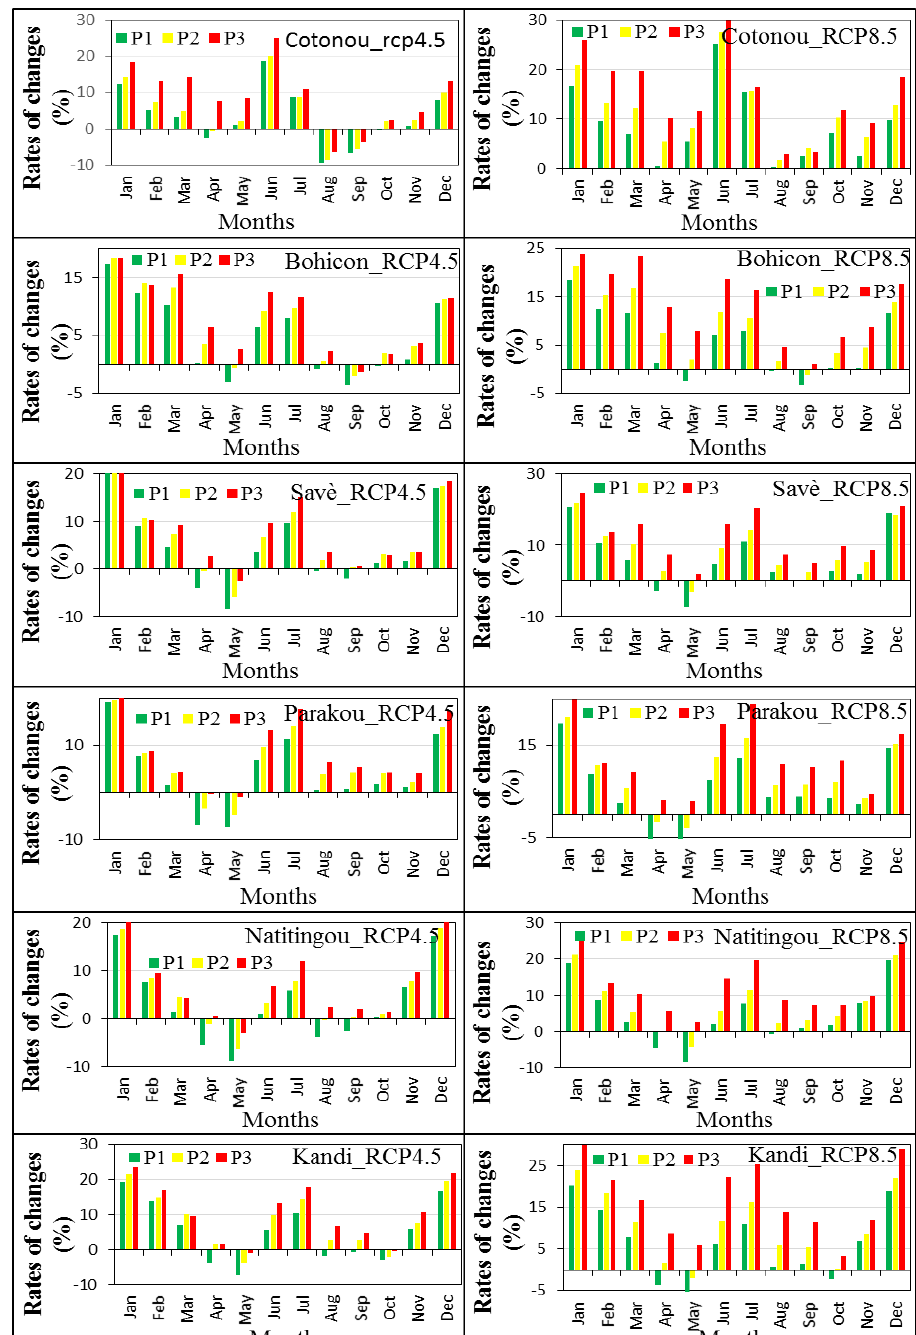
Figure 8. Rates of changes in future monthly PET relative to the baseline period.